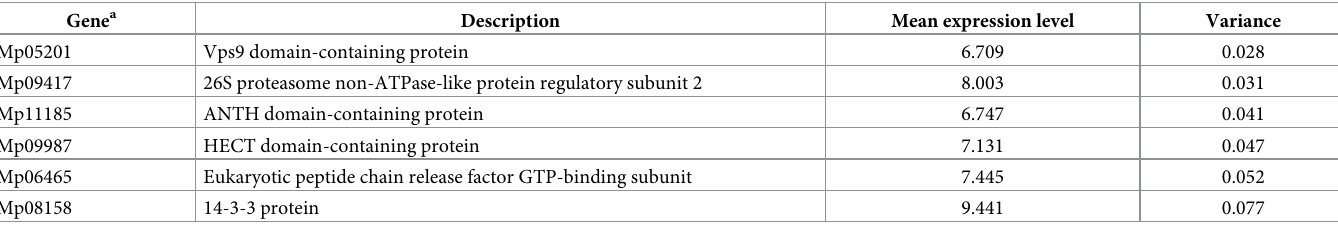
Table 2. List of genes selected based on publicly available RNA-seq data. Gene